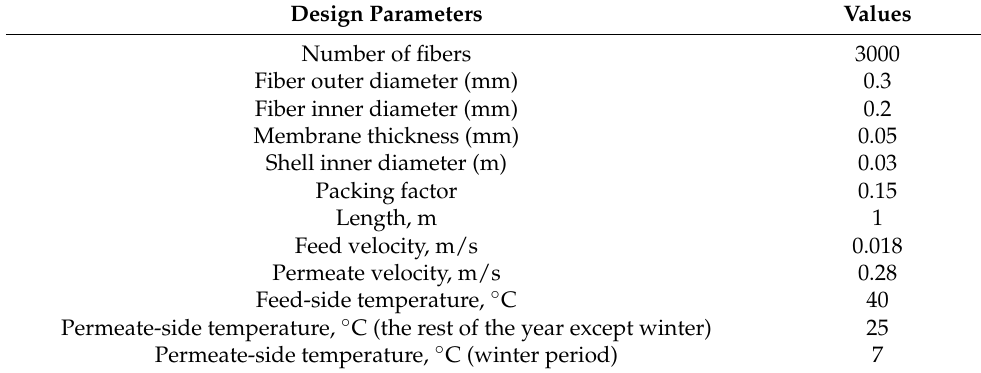
Table 2. MD design parameters.